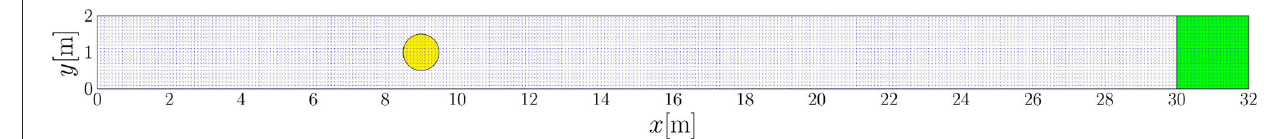
FIGURE 2 | Periodically oscillating flow: configuration of the cylinder confined in the channel. In the green fringe region the inflow is imposed. The cylinder is modeled in the yellow fringe region with E u =